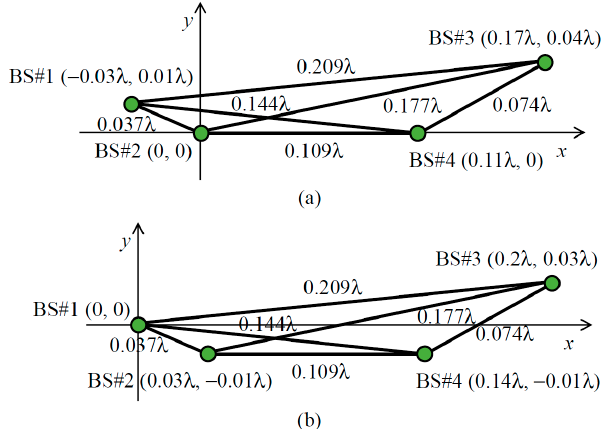
Figure 8. Arrangement of the virtual point sources to achieve the BS correlation at φ = 0° in Figure 5: ( a ) before translating; ( b ) after translating.